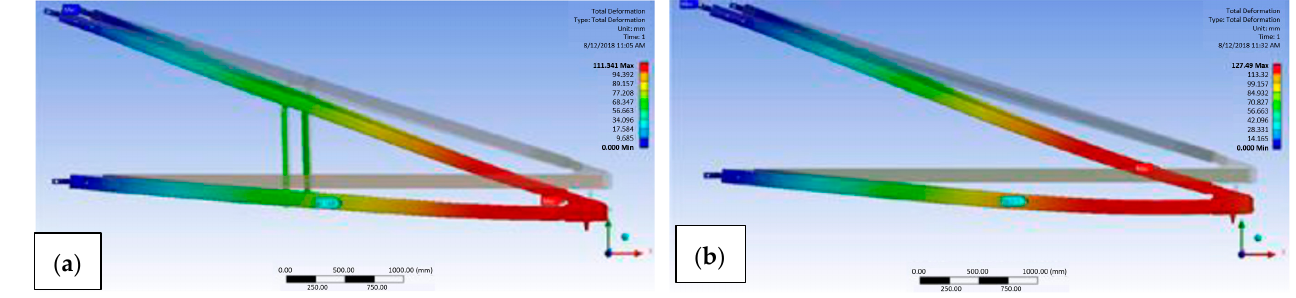
Figure 13. Comparison of simulated deformation experienced by cross arm ( a ) with and ( b ) without bracing [64].